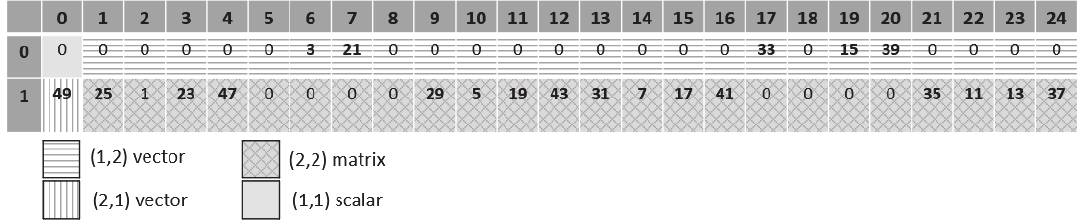
( θ ) for the three-phase IM with 49 bars (in line 1, 17 (cid:4666)θ(cid:4667) for the three ‐ phase IM with 49 bars (in line 1, 17 αβ (cid:3209)(cid:3210)